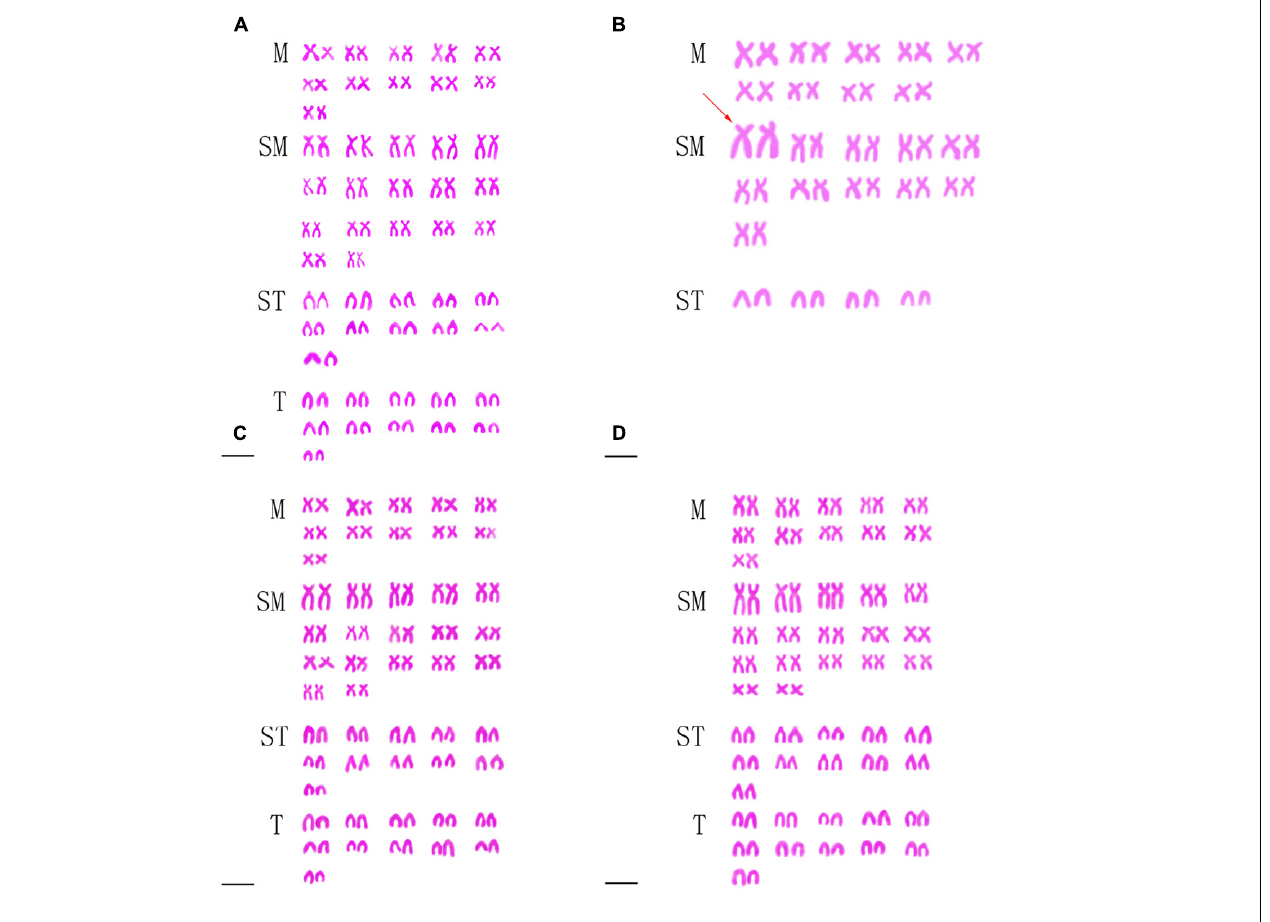
FIGURE 3 | Karyotypes of KOC, BSB, RCC-L, and GF-L. (A) The karyotype of KOC is 22m + 34sm + 22st + 22t. (B) The karyotype of BSB is 18m + 22sm + 8st. (C) The karyotype of RCC-L is 22m + 34sm + 22st + 22t. (D) The karyotype of GF-L is 22m + 34sm + 22st + 22t. Bar = 3 µ m. The red arrow indicates the two largest submetacentric